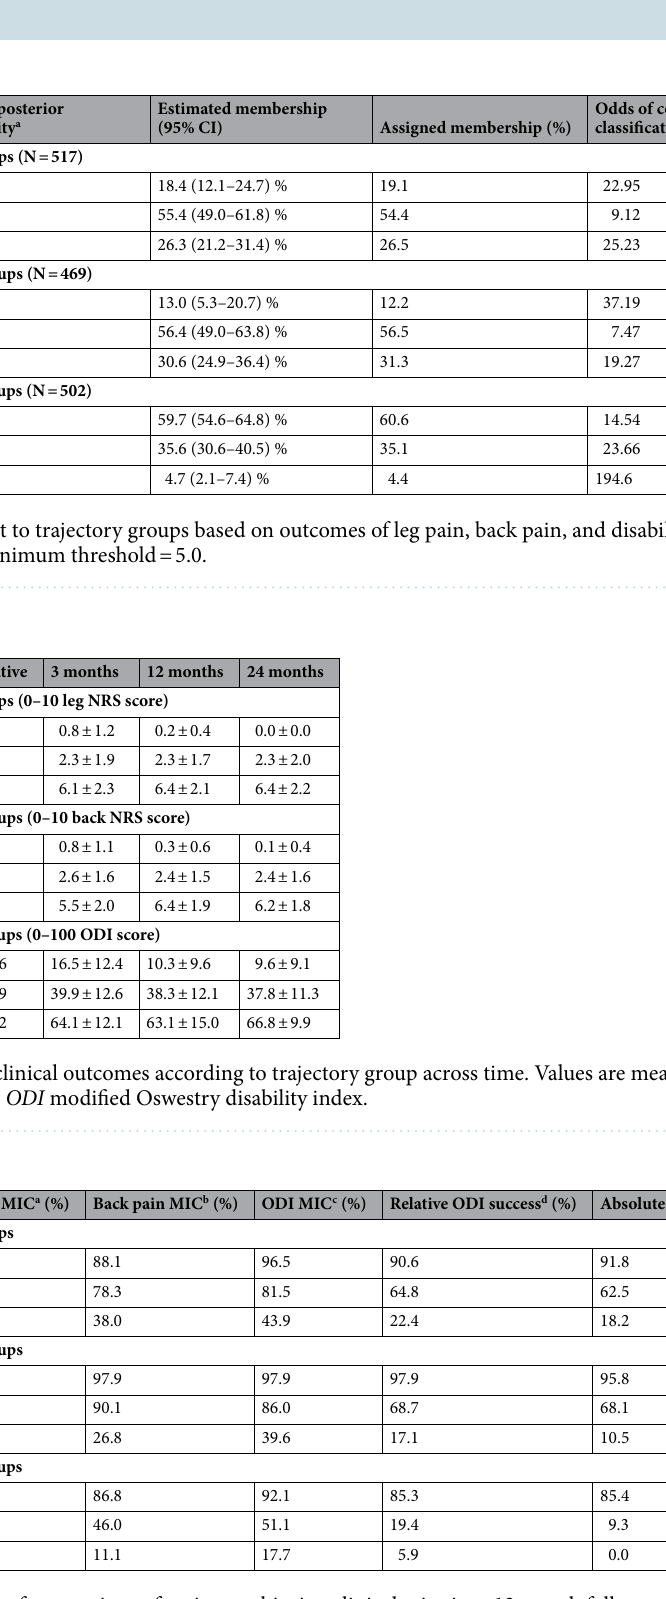
Table 4. Breakdown of proportions of patients achieving clinical criteria at 12 month follow-up. Statistical significance ( p < 0.001) was obtained for the between-group differences in the proportion of patients meeting each of the clinical criteria. Green ≥ 75%; yellow 50–74%; red < 50%. MIC minimal important change, ODI modified Oswestry disability index. a ≥ 30% reduction in NRS for leg pain. b ≥ 30% reduction in NRS for back pain. c ≥ 30% reduction in ODI. d ≥ 50% reduction in ODI. e ODI score ≤ 22.